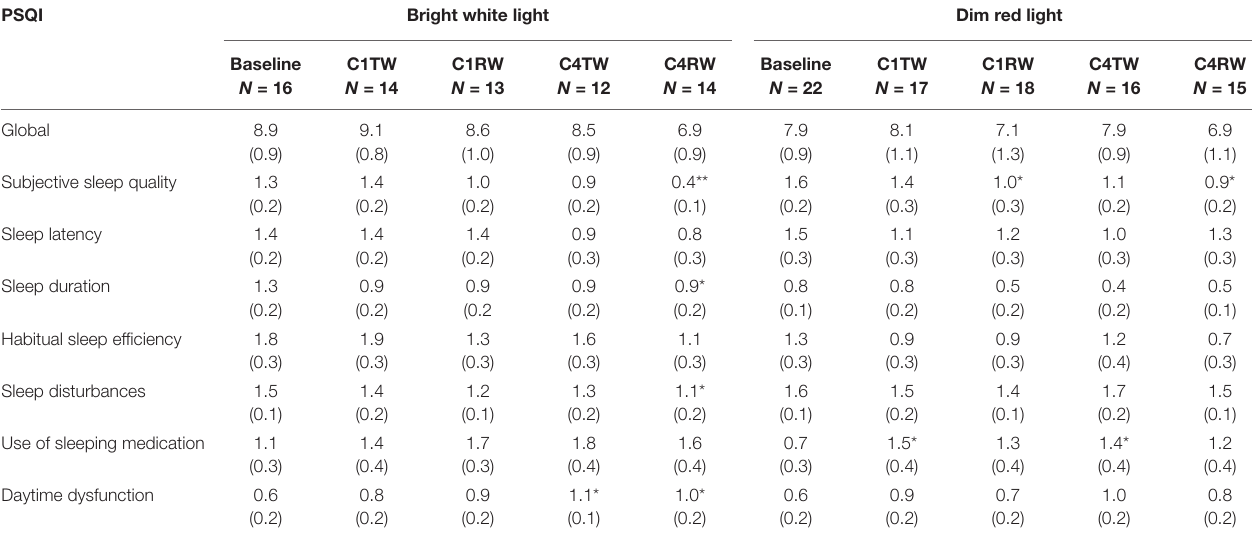
TABLE 2 | Mean ( SE ) Pittsburgh sleep quality index (PSQI) total and component scores by group condition and mixed model analysis. PSQI Bright white light Dim red